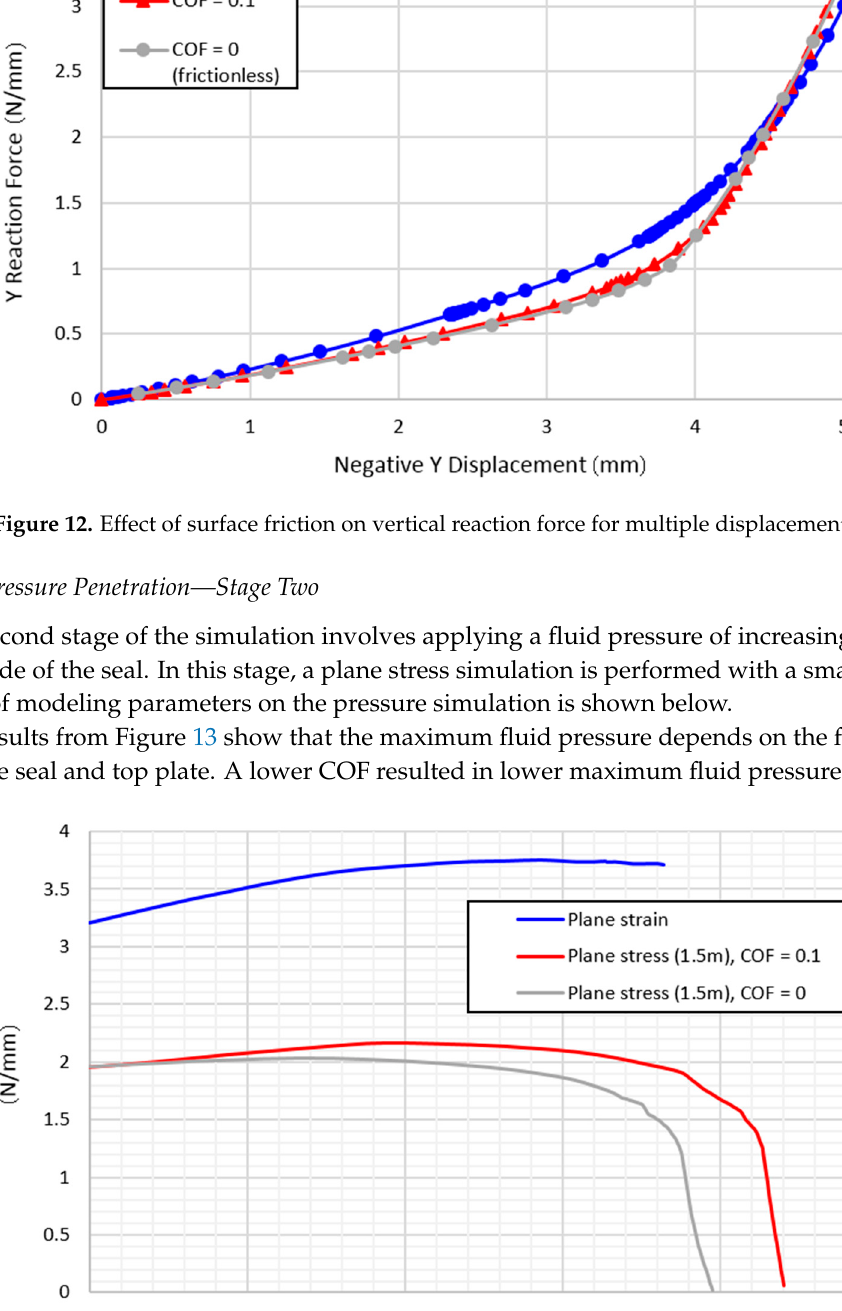
( b ) Figure 11. Contour plot of equivalent stress for simulations: ( a ) Plane Stress Assumption; ( b ) Plane Strain Assumption. As expected, the plane stress assumption resulted in lower vertical load required to achieve a displacement of − 5 mm (1.95 N/mm vs. 3.27 N/mm). The difference in loading between the plane strain and plane stress assumption is significant (40%). Hence, for a conservative prediction, the following assumptions are used: 